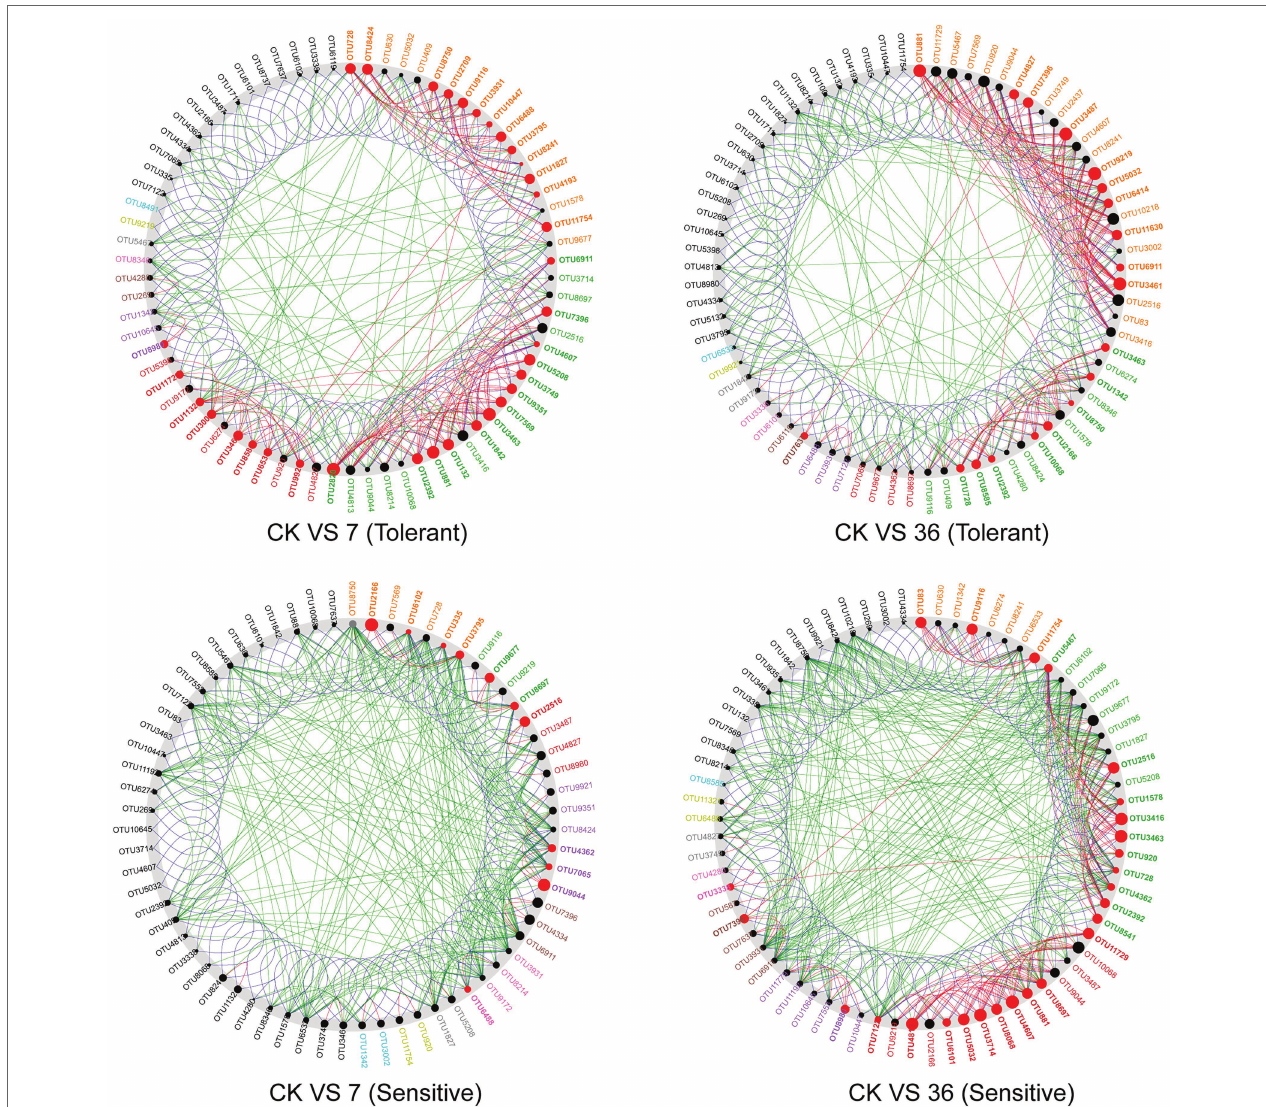
FIGURE 7 | A common sub-network view with the “driver” node highlighted. All nodes belonging to the same community have been randomly assigned a similar color. Gray OTU nodes represent nodes that are present in both cases, but interact directly with the common subnetwork in either the case or control group. The size of the nodes was proportional to their NESH scores, and a node was colored red if its spacing between the control and study groups increased. Large and red nodes are particularly important “drivers.” CK VS 7 (36; tolerant or sensitive), network comparison between soybean-corn rotations and 7 (36) years continuous cropping for tolerant or sensitive